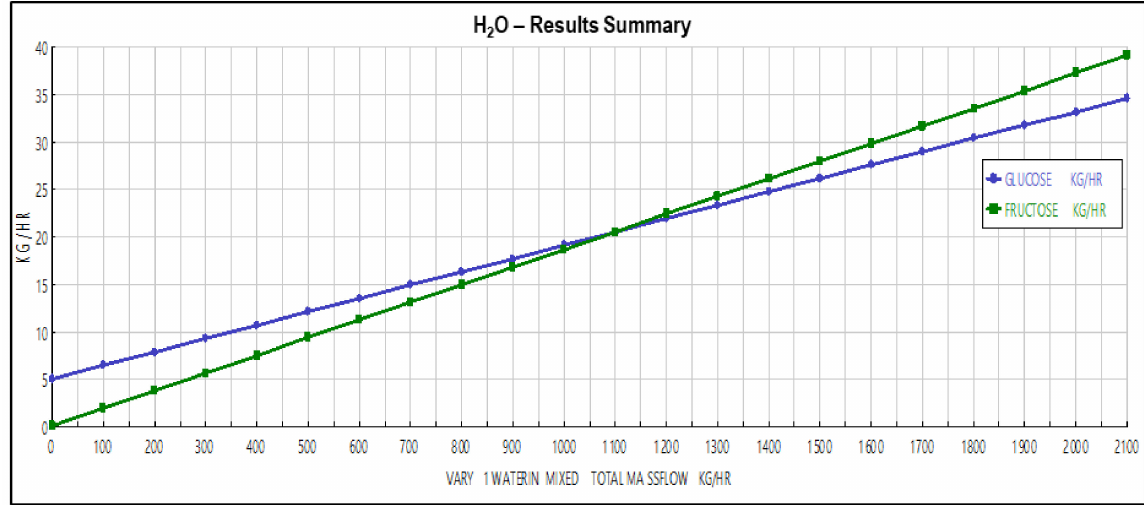
Figure 6. Effect of water flow rate on glucose and fructose recovery from date